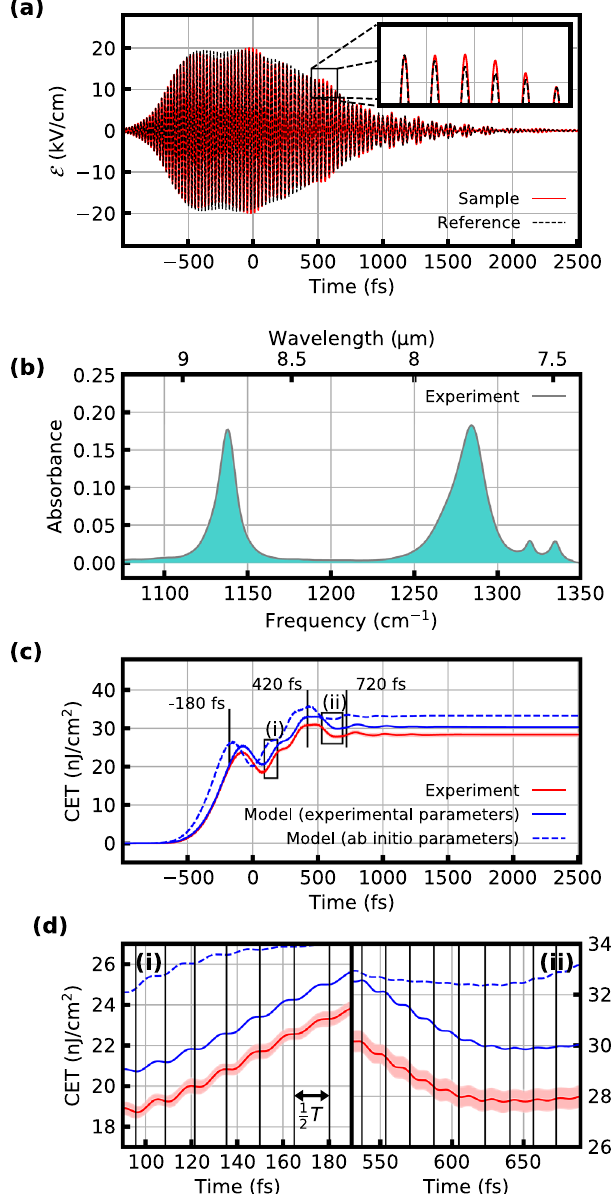
Fig. 3 | Chirped-pulse excitation (CPE). a Electric fi eld of the chirped excitation pulse after transmission through a 30- μ m thick layer of water (black, dashed) and 10-mg/ml solution of DMSO 2 in water (red). b Absorbance, calculated from the measurements in a . c Coherent energy transfer CET( t ) between the excitation fi eld andtheDMSO 2 solution,extractedfromtheexperimentaldata(solidredline:mean value of three consecutive measurements, each comprising 20 traces, shaded red area: error corridor determined with Gaussian error propagation, see Methods), from modeling with the fi tted Lorentzian parameters (solid blue line, see Fig. 2), and with Lorentzian parameters obtained ab initio (dashed blue line). The maxima of CET( t ) around − 180 fs, 420fs, and 720fs are marked by vertical black lines (see also the discussion in the main text and Fig. 4d). d Magni fi ed displays of the sec- tions encased by the dashed black rectangles (i) and (ii) in c , revealing the sub- optical-cycle structure of absorption and stimulated emission. The zeros of the electric fi eld are marked by vertical black lines, showing that each absorption or T ) of the electric fi emission step corresponds to one half-cycle ( 1 2